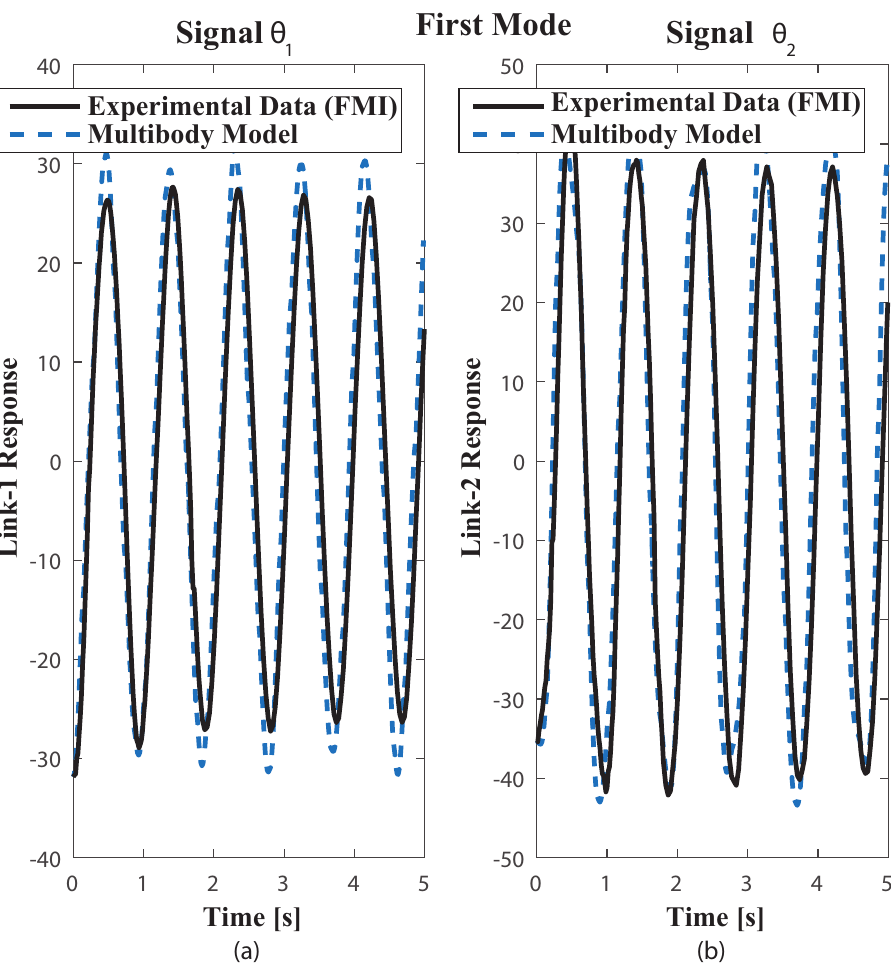
Figure 7. Plots of Experimental FMI and Multibody model free vibration motion responses closely to the first mode. Initial Conditions: first link deviation from vertical Θ 1 = 31.84 ◦ , clockwise, second link deviation from vertical Θ 2 = 26.39 ◦ ,